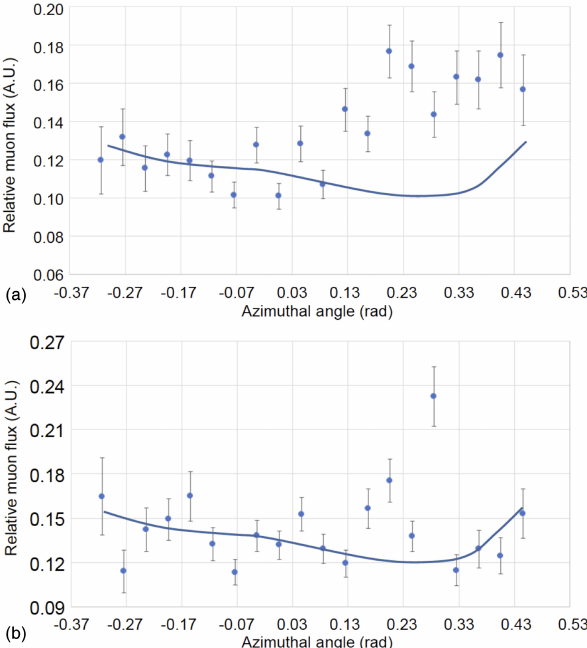
Figure 4. Azimuthal distribution of the relative muon flux for ele- vation angles of (a) 100 and (b) 92mrad. The solid curves indicate the expected horizontal muon flux